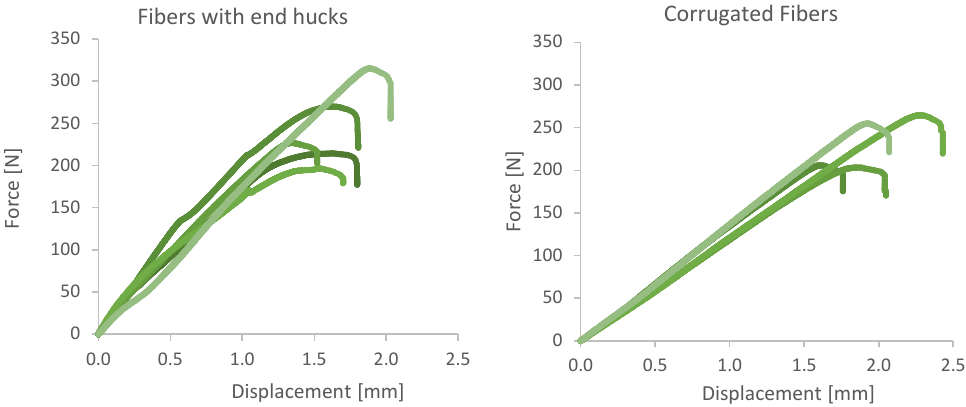
Figure 13. Fiber pullout tests of specimen with vertical fiber reinforcement.